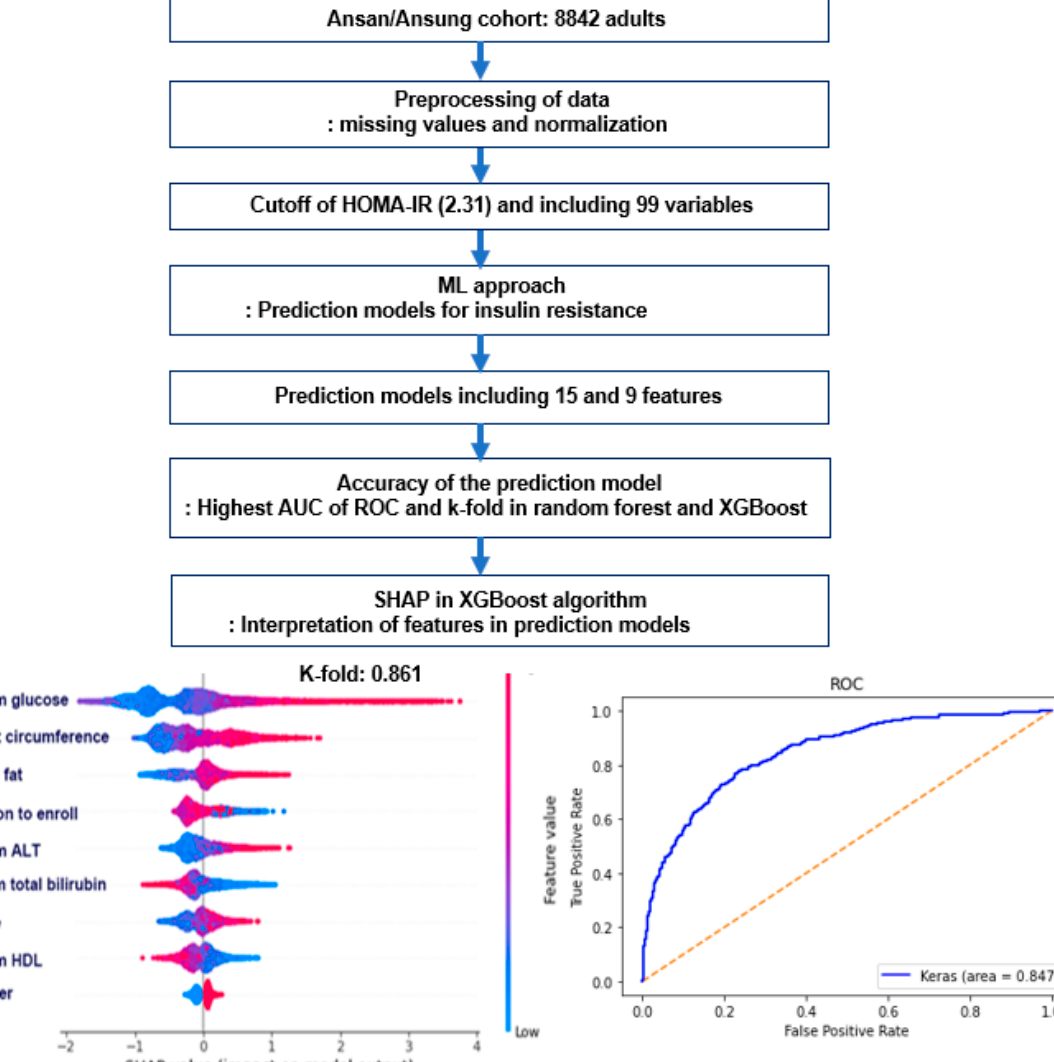
Figure 6. Summary of the main findings to explore the prediction model for insulin resistance. HOMA-IR, homeostasis model assessment of insulin resistance.